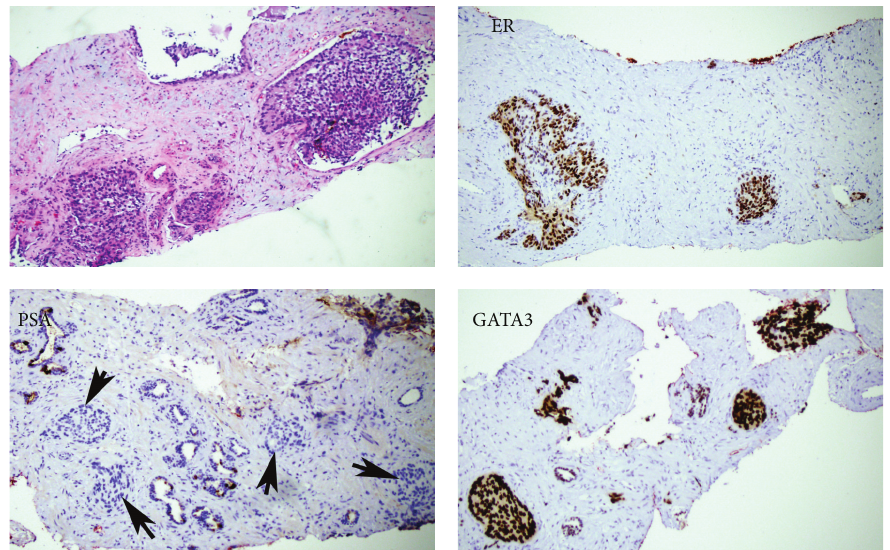
Figure 2: Prostate needle core biopsy shows infiltrative nests of hyperchromatic nuclei with modest eosinophilic cytoplasm separated by fibrous stroma with a desmoplastic reaction on H&E. Immunohistochemical stains show nuclear staining for ER and GATA3 and negative staining by